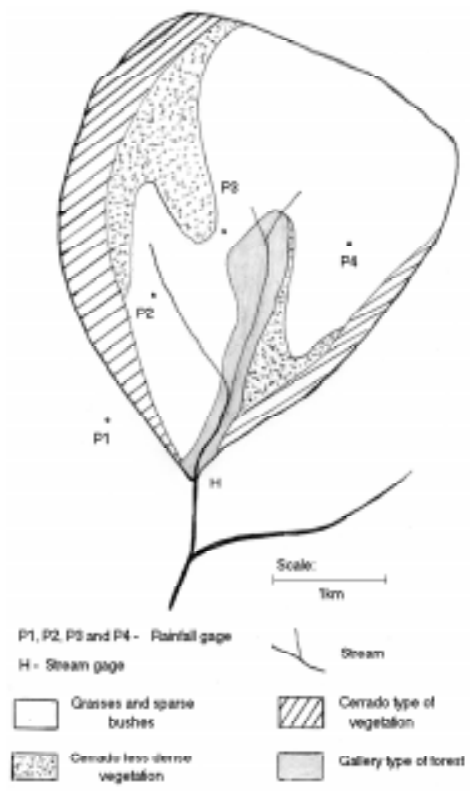
Figure 1. Capetinga watershed delimited by continuous line showing rain gage distribution. Dashed line represents studied area and H represents the stream gage